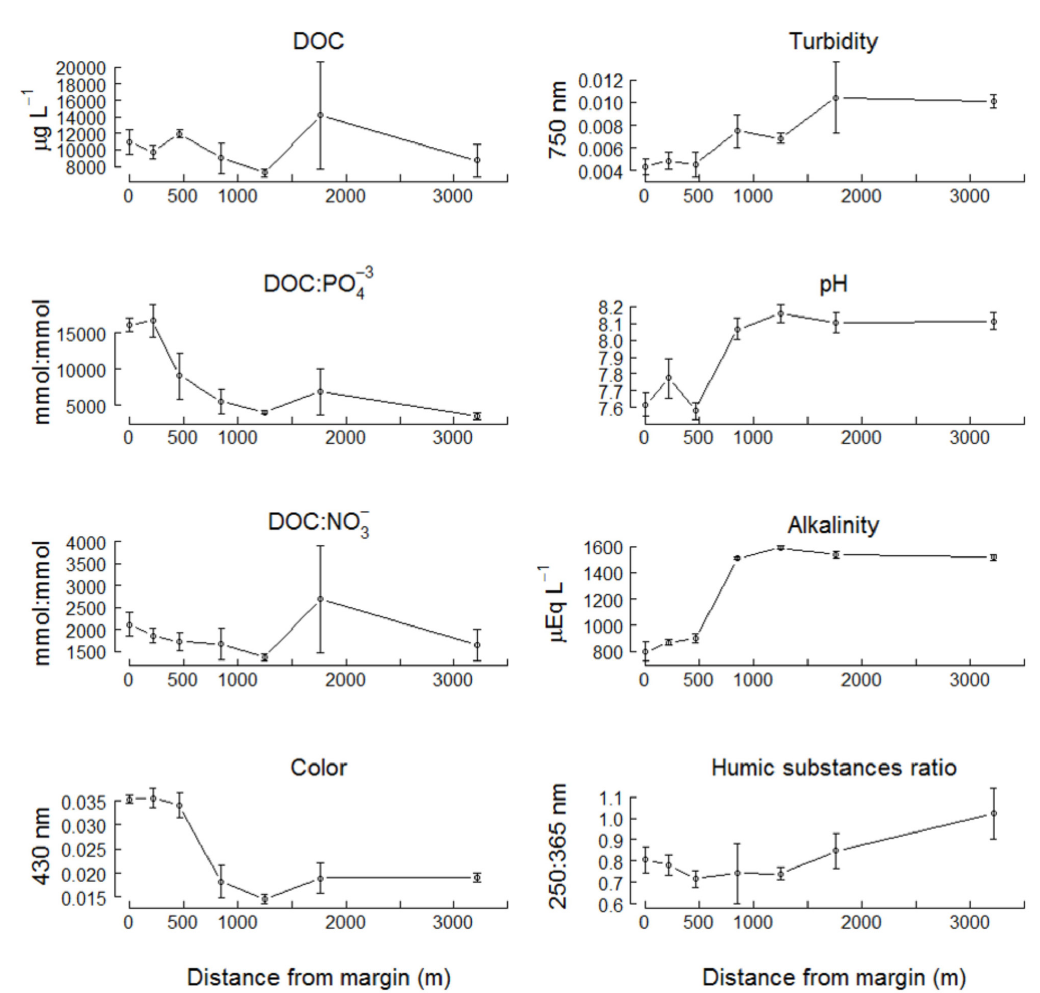
Figure 3. Gradient of the main limnological variables along a transect running from a littoral macrophyte dominated zone to a phytoplankton dominated pelagic zone in Lake Mangueira. Bars represent standard deviations (n = 3).